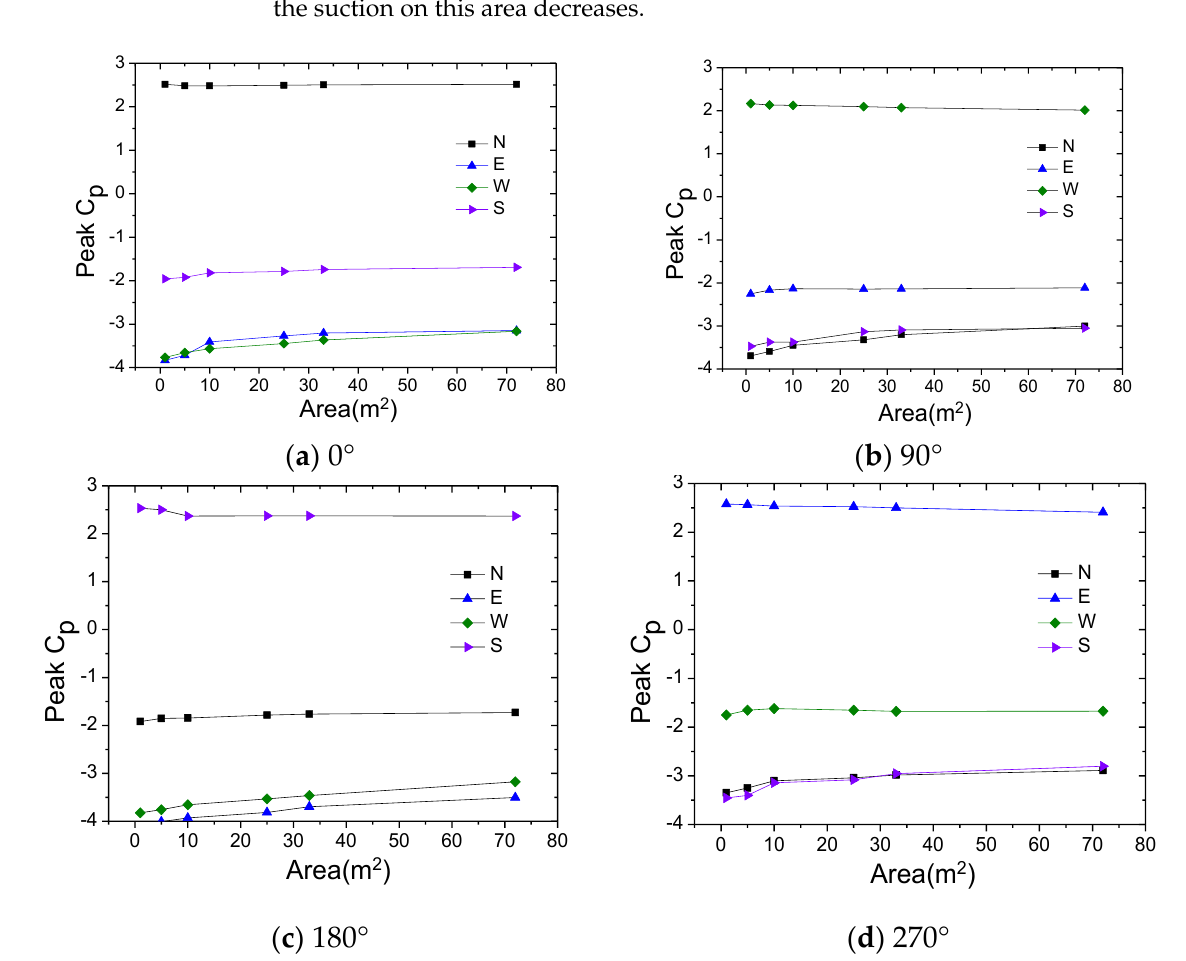
Figure 11. Comparison of the area-average peak pressure coefficients of each facade for different area size under different wind direction: ( a ) 0°, ( b ) 90°, ( c ) 180°, ( d ) 270°.